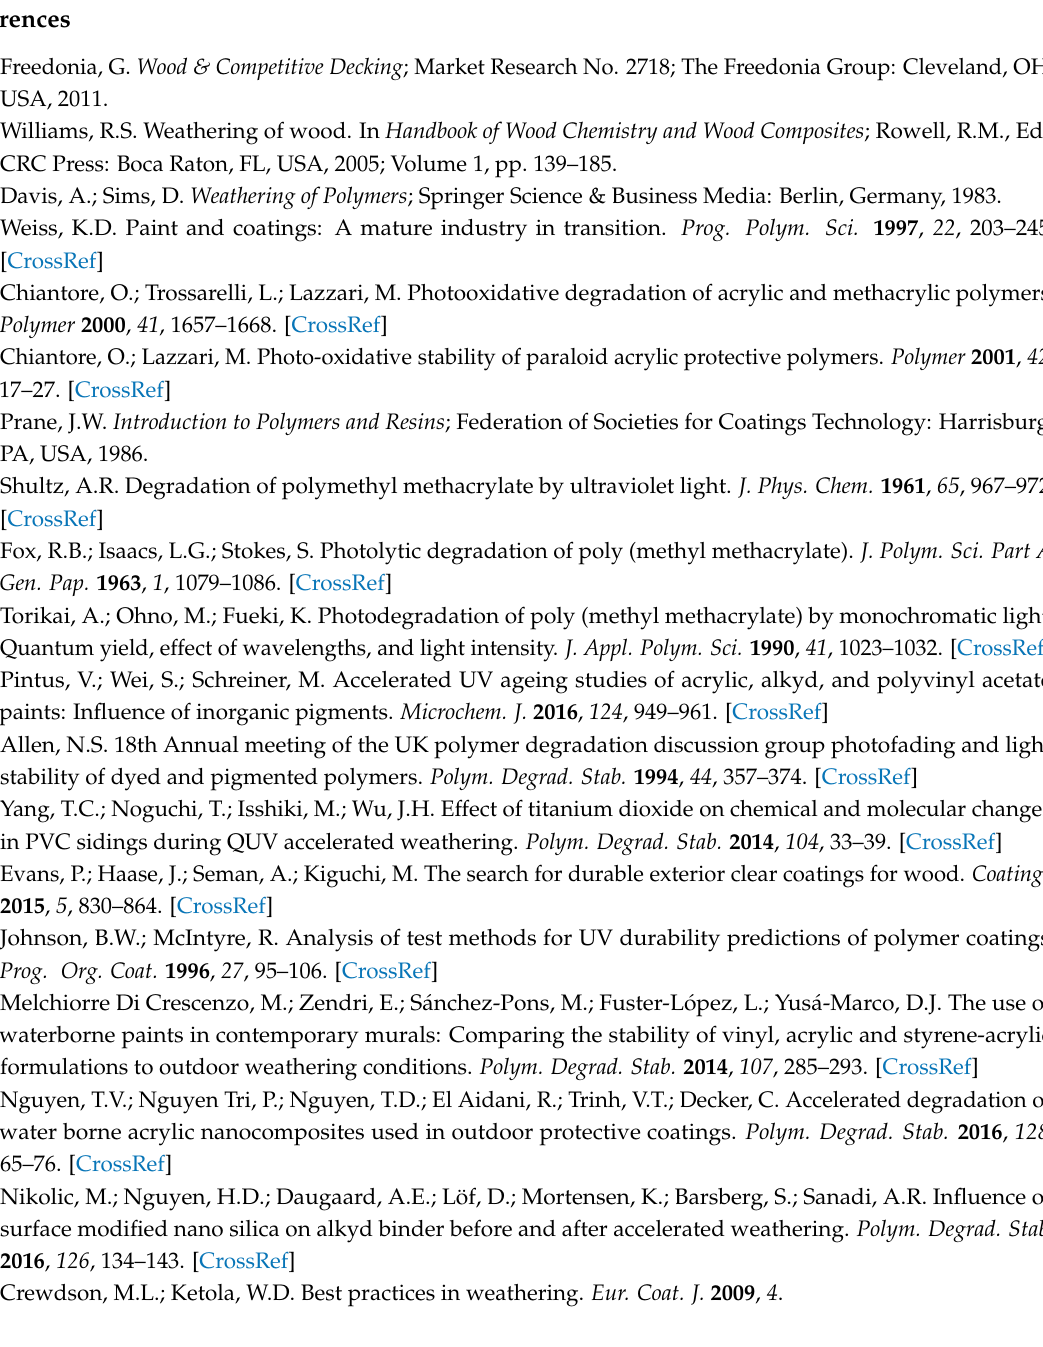
Quebec, Table S6: Quantum energy received by samples after exposure in Quebec, Table S7: Quantum energy received by samples after exposure in a